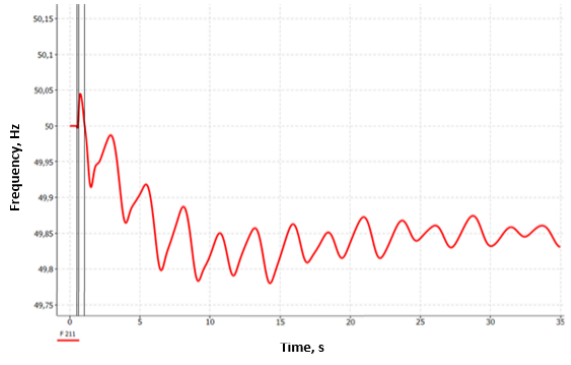
Fig. 4. System frequency dynamics